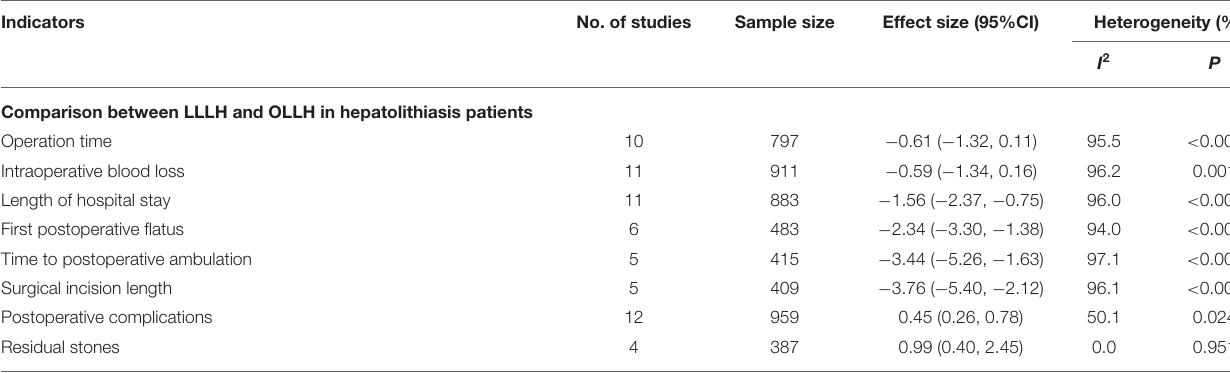
TABLE 2 | Summarized results of included